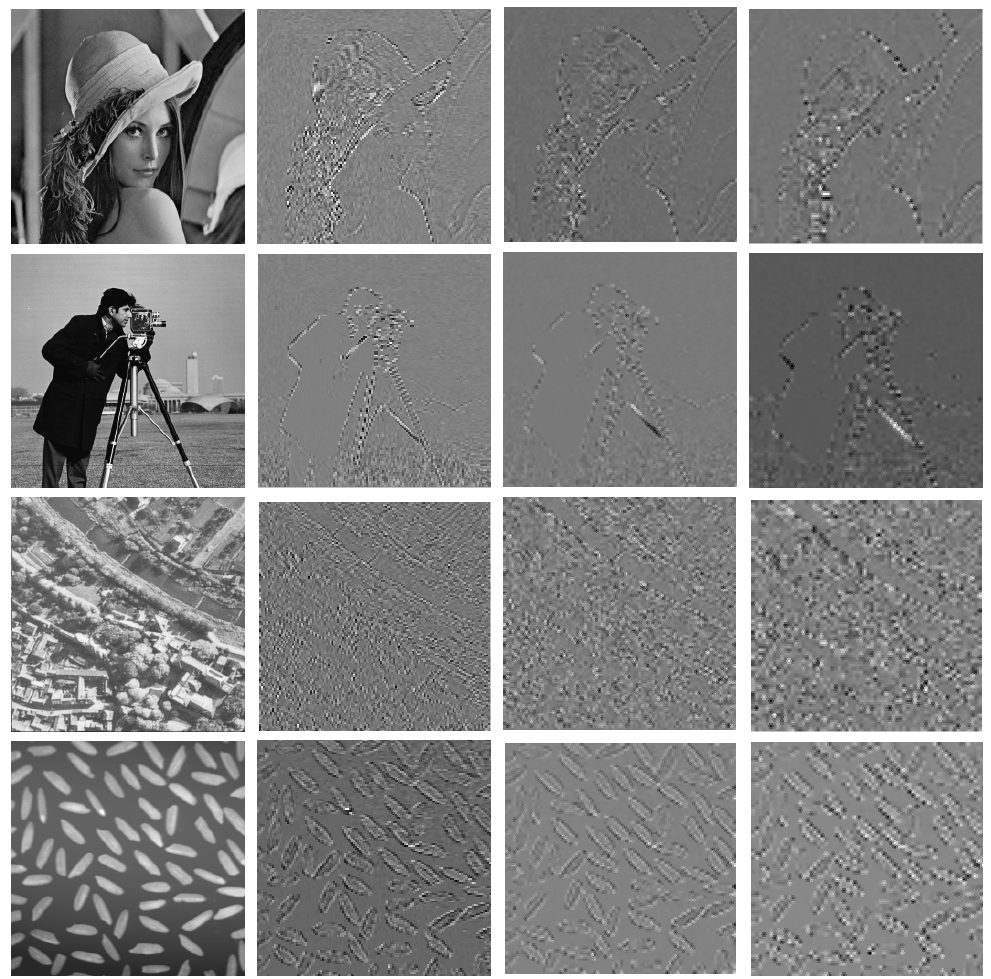
Figure 1: The first column: orinal images; the second column: edges by M third column: edges by M 3 ; the fourth column: edges by M 4